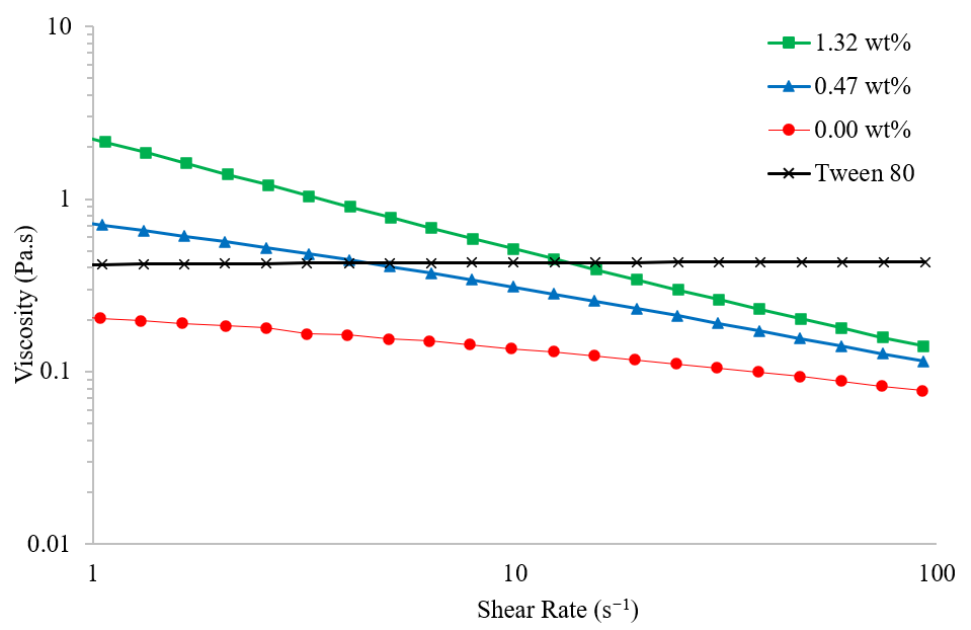
Figure 6. Shear viscosity (Pa.s) of pristine PEDOT:PSS/Tween 80 solutions with surfactant concen- tration 0.00 (red circle), 0.47 (blue triangle), and 1.32 wt% (green square); and pure Tween 80 (black cross) for varying shear rates (s − 1 ).